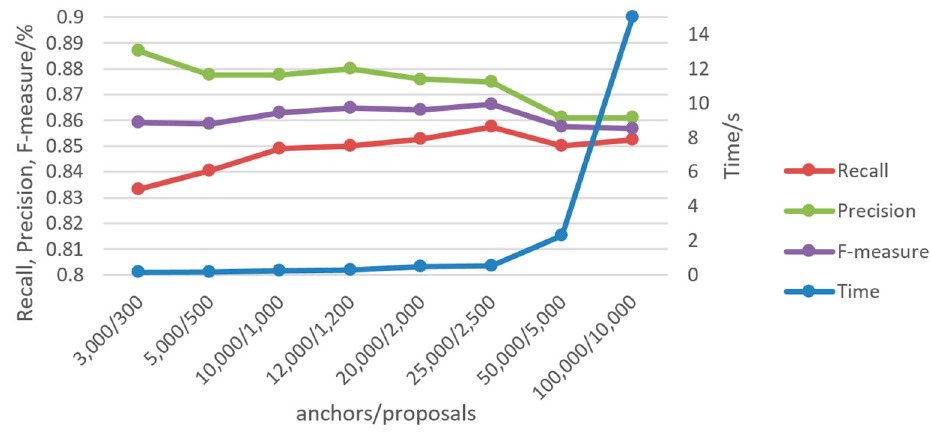
Figure 8. The impact of different combinations of anchors and proposals on the experimental results.